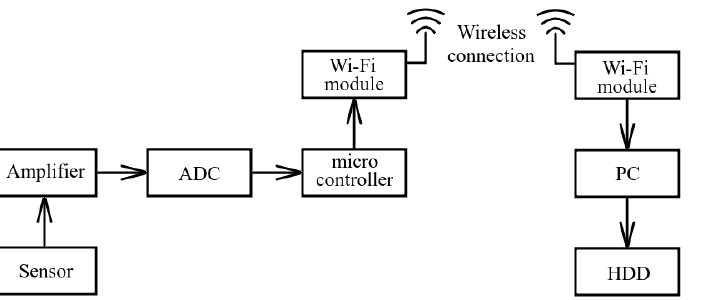
Figure 5. Block scheme of the acoustic receiving system with data transmission channel based on Wi-Fi modules.